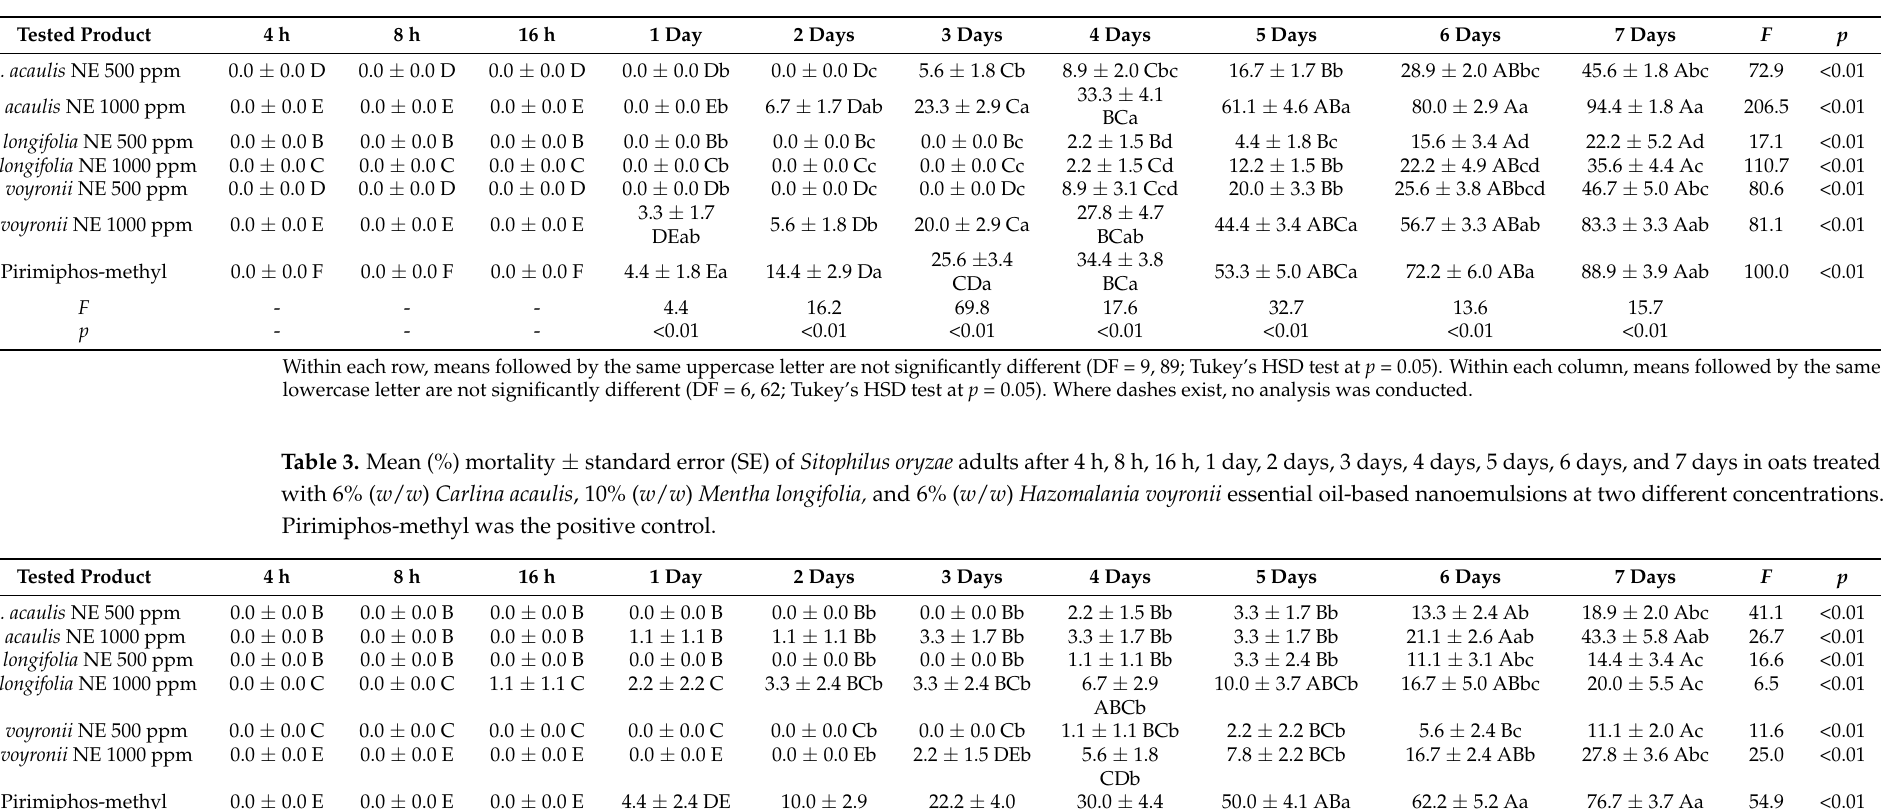
Table 2. Mean (%) mortality ± standard error (SE) of Sitophilus oryzae adults after 4 h, 8 h, 16 h, 1 day, 2 days, 3 days, 4 days, 5 days, 6 days, and 7 days in barley treated with 6% ( w / w ) Carlina acaulis , 10% ( w / w ) Mentha longifolia, and 6% ( w / w ) Hazomalania voyronii essential oil-based nanoemulsions at two different concentrations. Pirimiphos-methyl was the positive control.